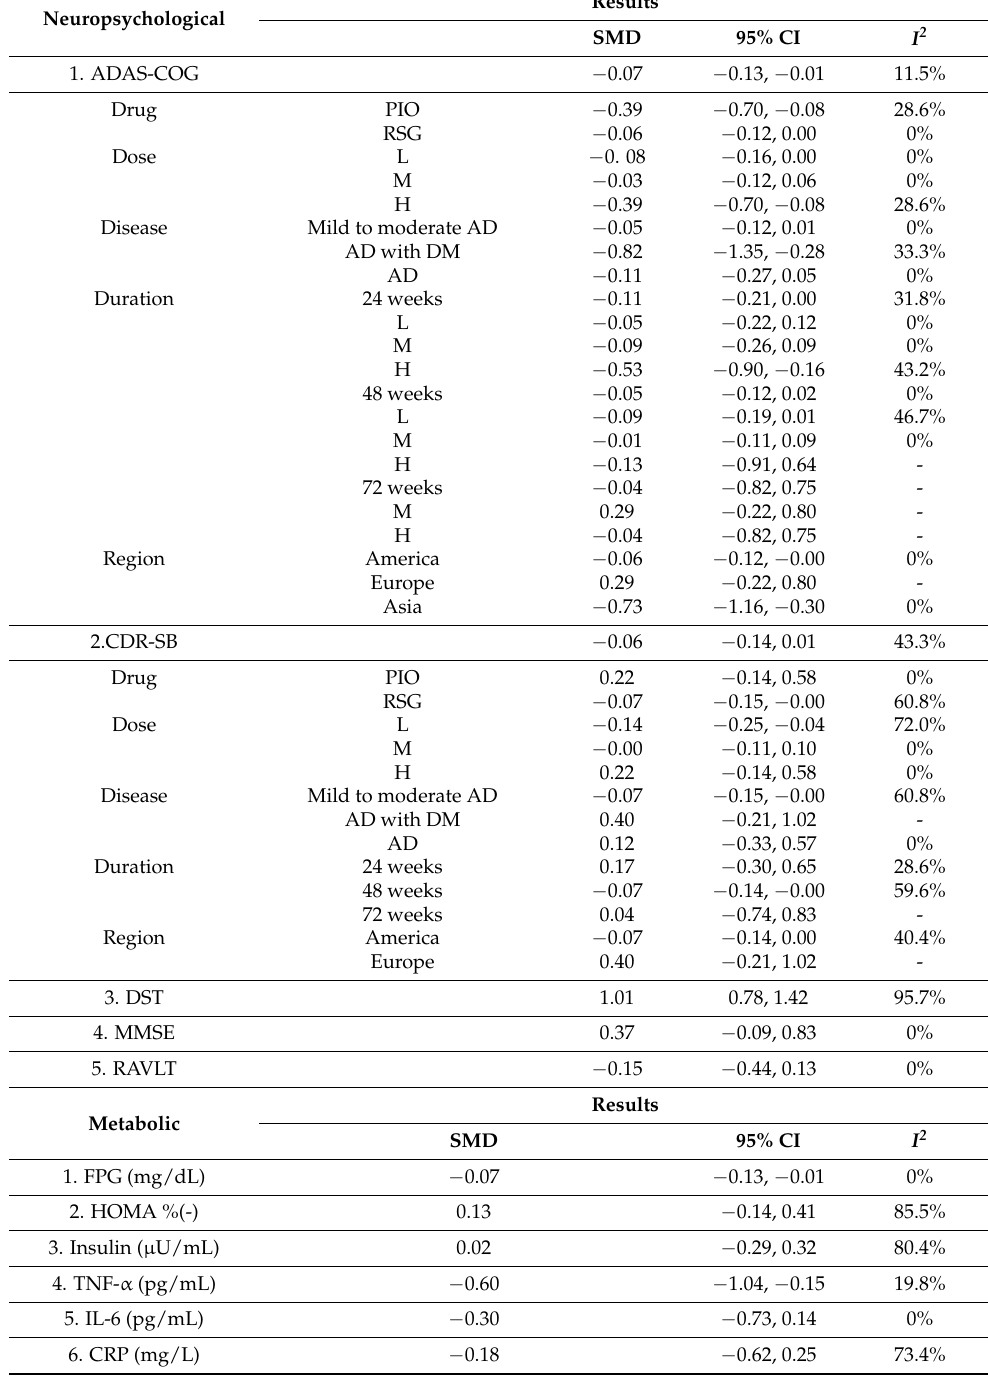
Table 3. Neuropsychological and metabolic